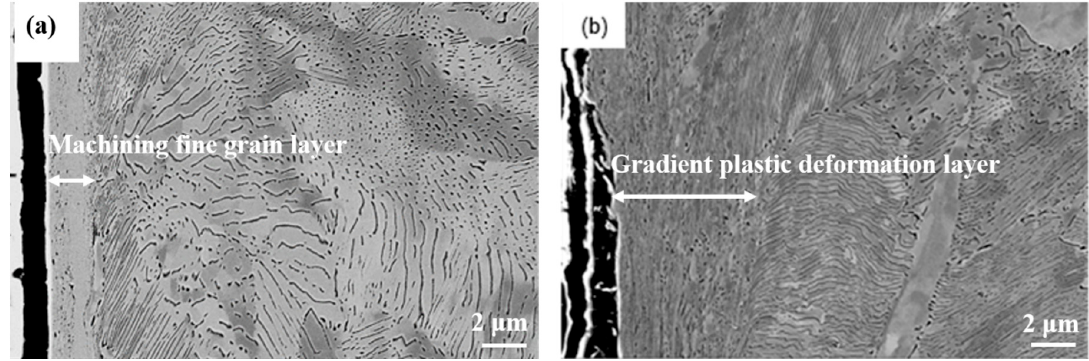
Figure 7. The SEM micrographs: ( a ) the grinding processing sample and ( b ) the sample after SURT with 0.4 MPa.